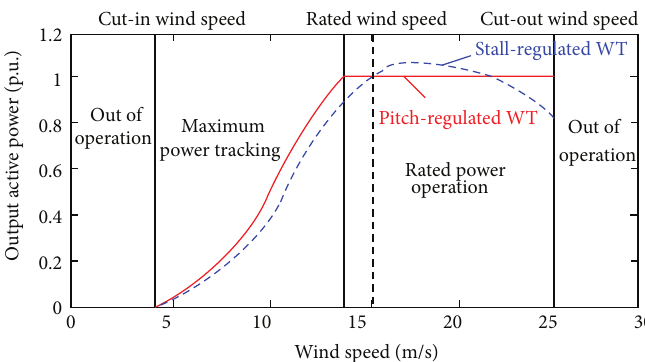
Figure 2: Power curves of fixed pitch and variable pitch wind turbines.